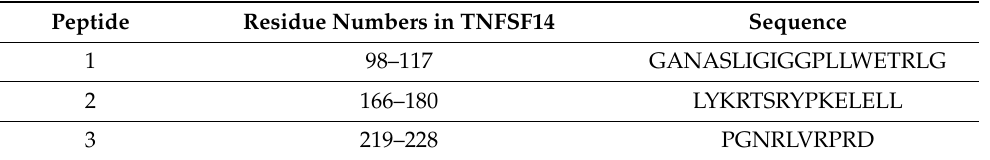
Figure 1. Computational alanine scanning reveals key regions of receptor contact by TNFSF14. Com- putational alanine scanning of TNFSF14 in complex with TNFRSF14 ( A ) and LT β R ( B ). Interaction between TNFSF14 region corresponding to peptide 2 with TNFRSF14 ( C ) and LT β R ( D ). Legend to panels C and D : grey—TNFSF14; pink—TNFRSF14/LT β R; green dashes—hydrogen bonds; cyan dashes—CH- π interactions; yellow dashes—nonpolar interactions. Table 1. TNFSF14 peptides identified by computational alanine scanning as major contributors to ligand-receptor binding